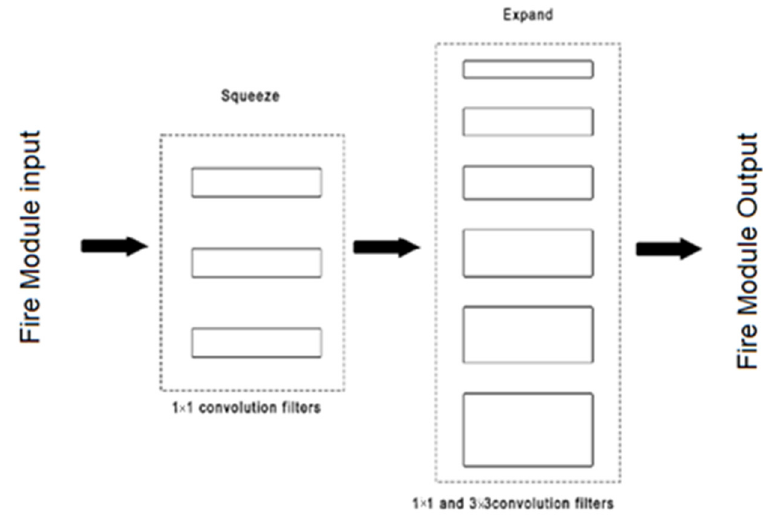
Figure 6. Micro-architectural view: convolution filters organization in the fire modules [30].